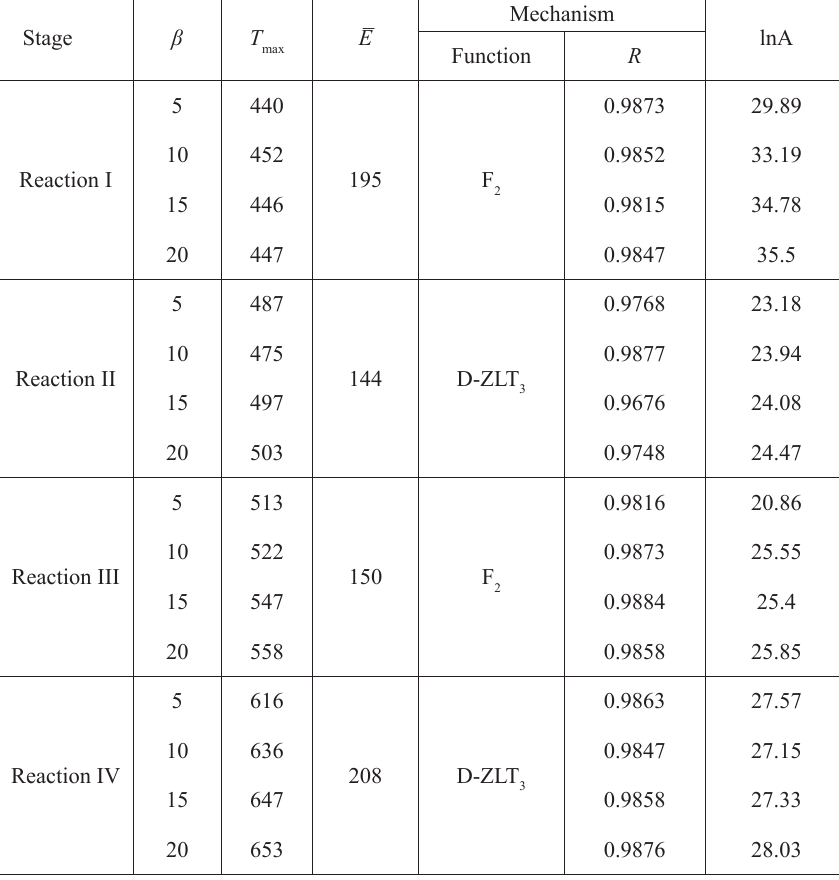
Table 2. Kinetic triplets of sub-reactions for the OS-Co oil shale